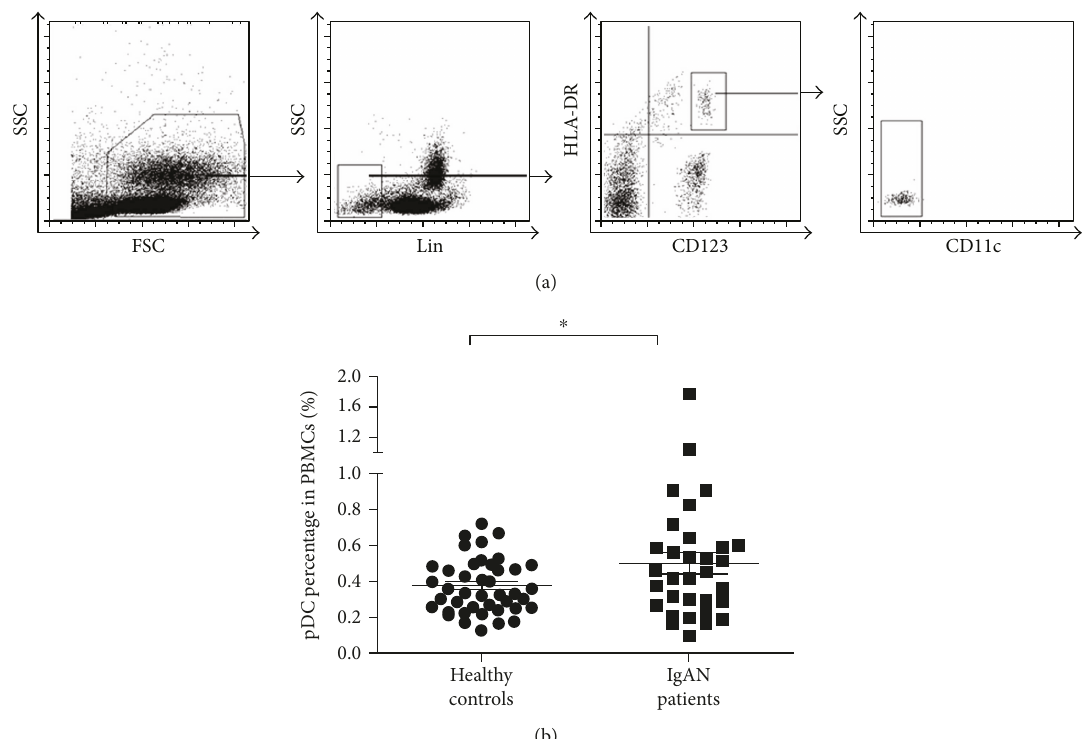
Figure 1: The percentages of pDCs were increased in PBMCs of IgAN patients. Peripheral blood mononuclear cells (PBMCs) of donors were prepared by fi coll-paque density centrifugation and subjected to fl ow cytometry analysis. (a) The surface phenotype of pDCs was de fi ned as Lin − CD123 high HLA-DR + CD11c − . (b) The percentages of pDCs in PBMCs from IgAN patients and healthy donors were analyzed. ∗ p < 0 05